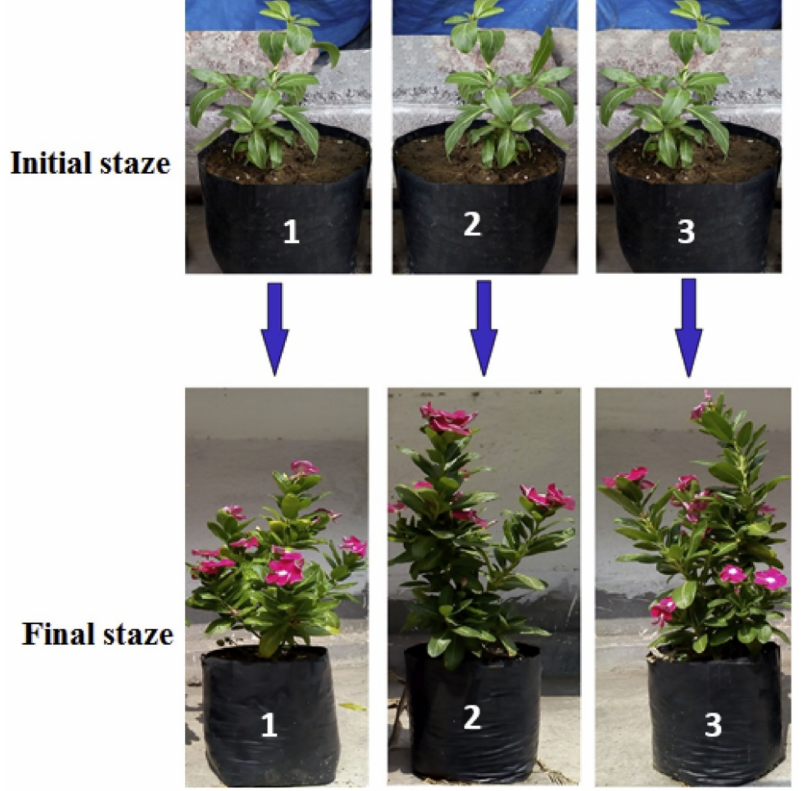
Figure 3. Plant growth comparison: ( 1 ) Control plant without fertilizer; ( 2 ) plant with collagen NPK fertilizer; ( 3 ) plant with commercial fertilizer; final stage is the 80th day after the soil fertilization. Reprinted with permission from ref. [52]. 2022,